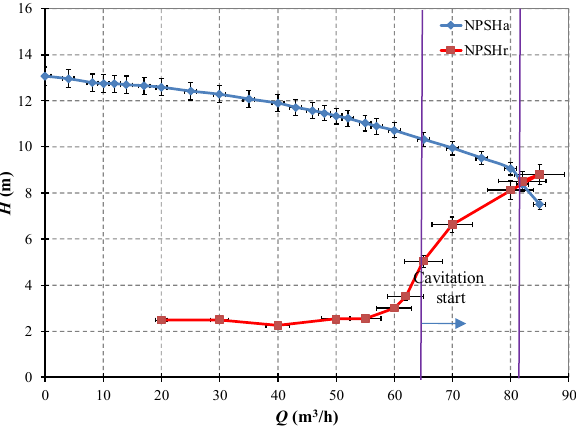
Figure 3. Cavitation characteristic curve of the centrifugal pump.